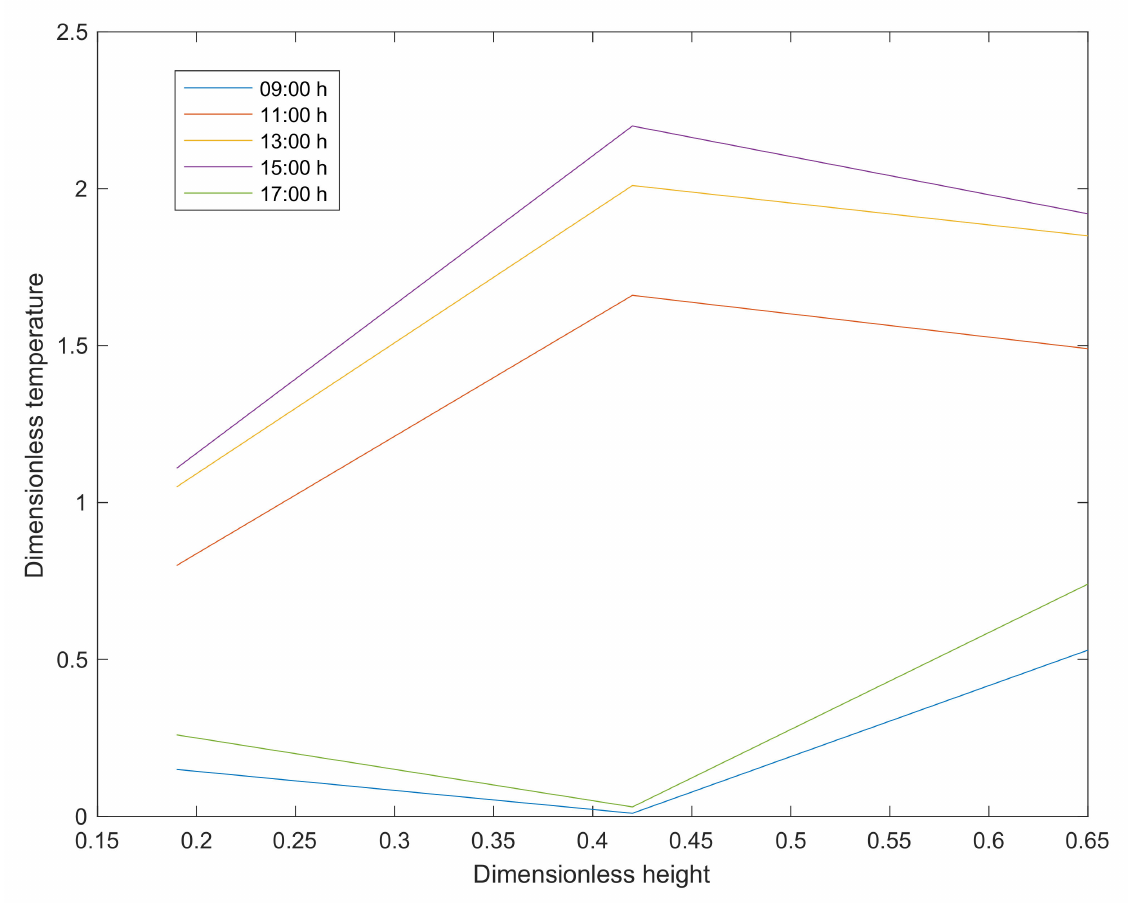
Figure 13. BIPVT dimensionless temperature and height (11 January